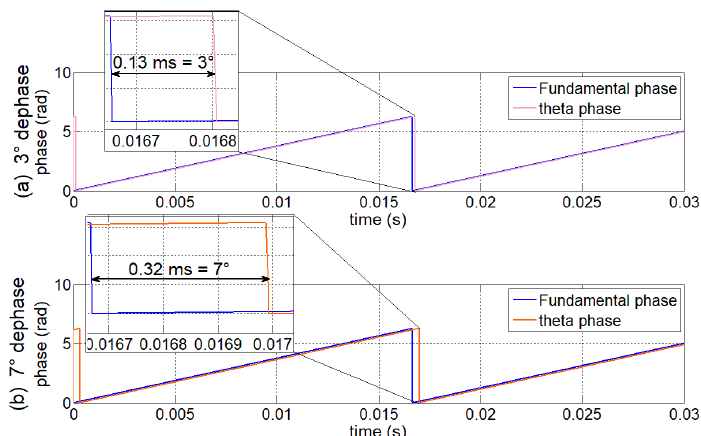
Figure 15. Variation of φ : ( a ) φ = 3°; ( b ) φ = 7°.